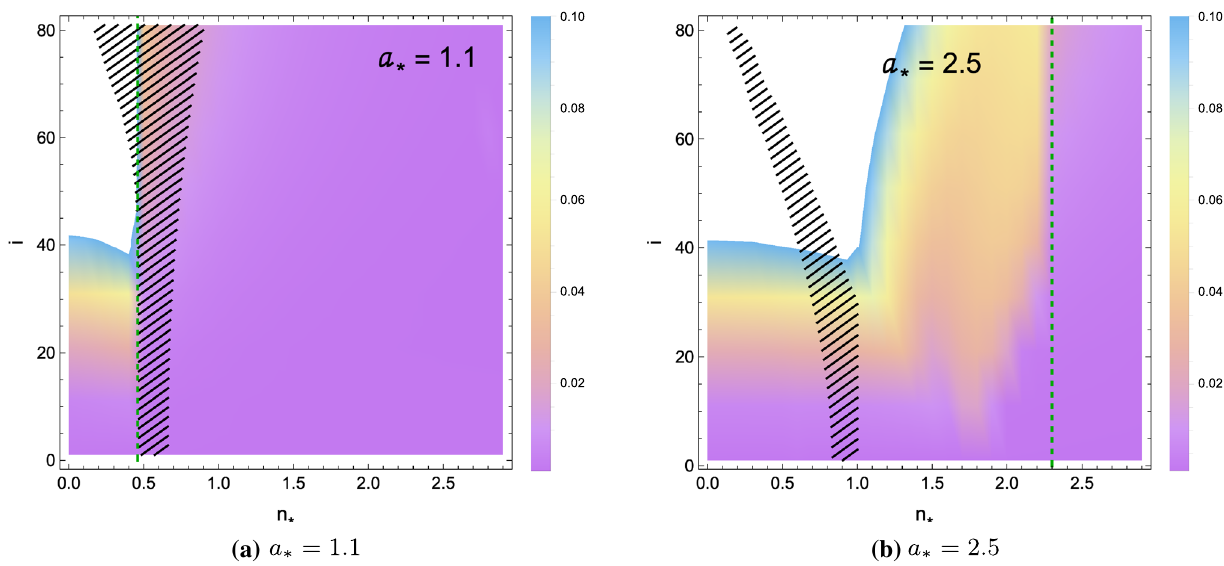
Fig. 4 Dependence of the deviation from the circularity of an object with KTN metric on i and n ∗ plane, for two different a ∗ values. These two panels illustrate one important property of the NUT parameter in general, i.e, it decreases the deviation from the circularity of the BH shadow. In each panel, the hatched region indicates the parameter space